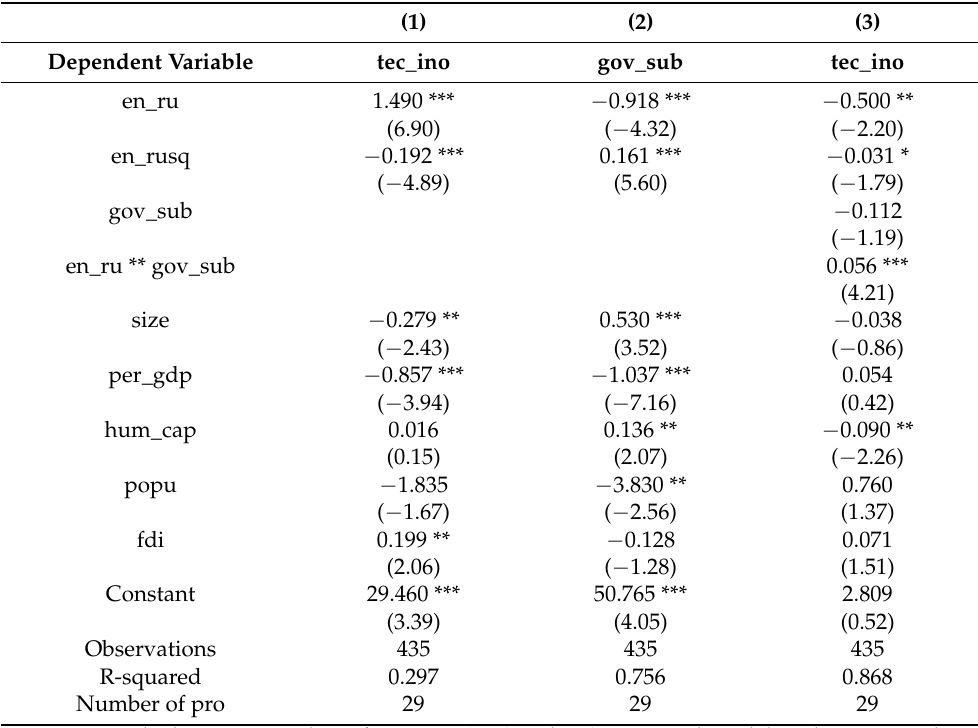
Table 7. The mediating effect of government